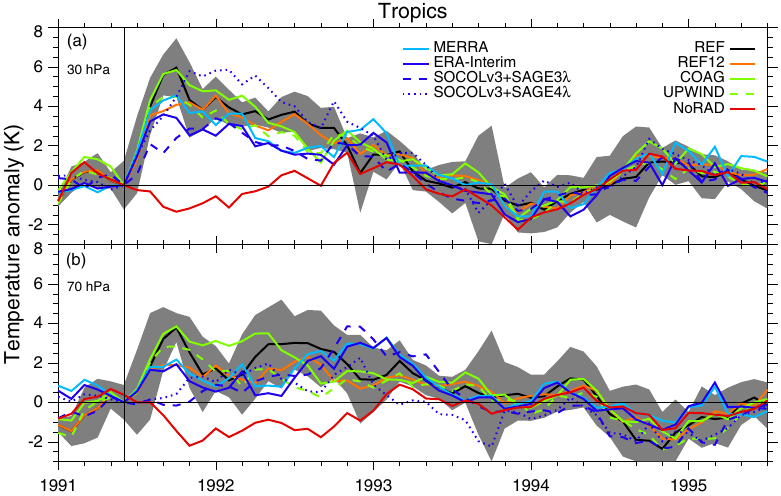
Figure 6. Zonal mean temperature anomalies from SOCOL-AER for the tropics (20 ◦ S–20 ◦ N) at 30hPa (a) and 70hPa (b) . Light and dark blue lines: MERRA and ERA-Interim temperature reanalysis data. Anomalies are computed by subtracting the annual cycle. Grey shaded area: 2 σ ensemble spread of the REF experiment. All other scenario curves are ensemble means.